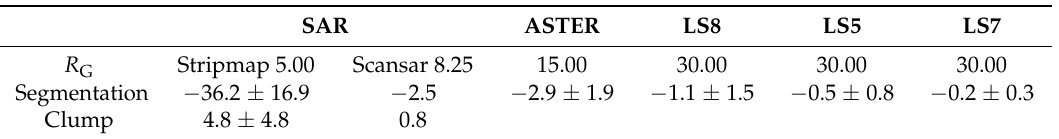
Table 5. Average reduction ( ± standard deviation) of inclusion and exclusion errors by applying segmentation and clumping on datasets with different geometric resolution. SAR ASTER LS8 LS5 LS7 R G Stripmap 5.00 Scansar 8.25 15.00 30.00 30.00